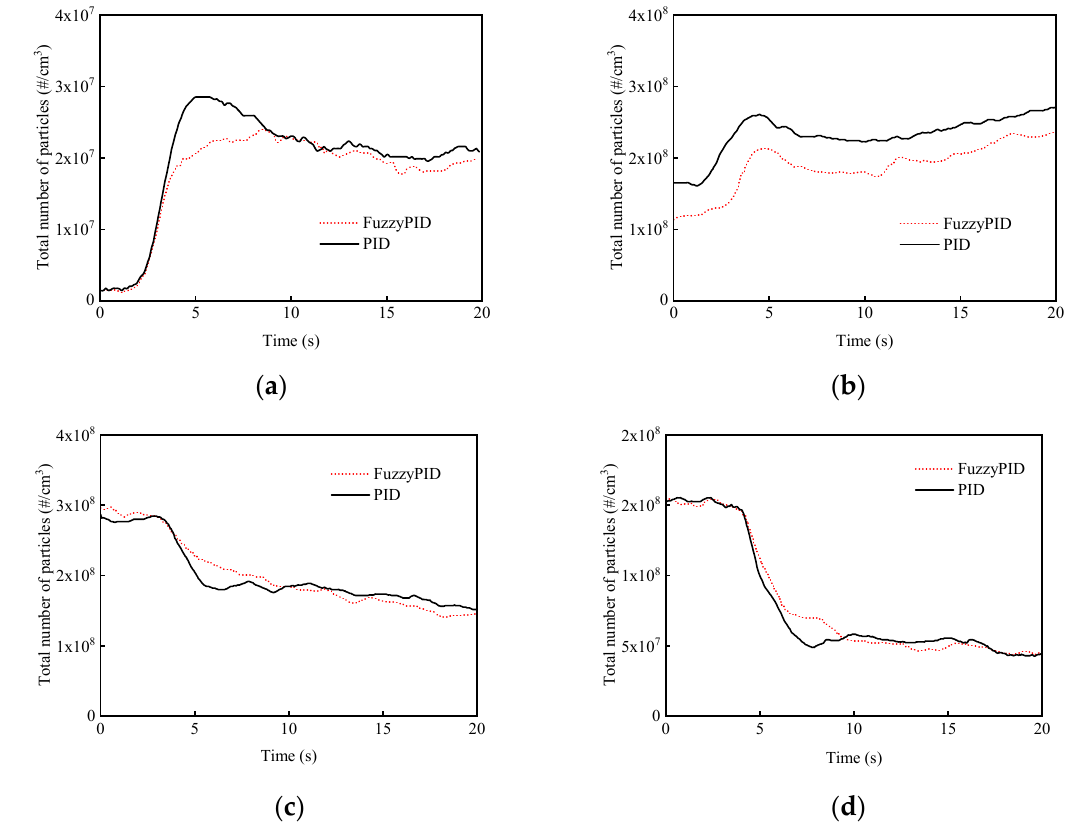
Figure 7. Particulate emission characteristics in the process of working condition switching: ( a ) switching 1; ( b ) switching 2; ( c ) switching 3; ( d ) switching 4.